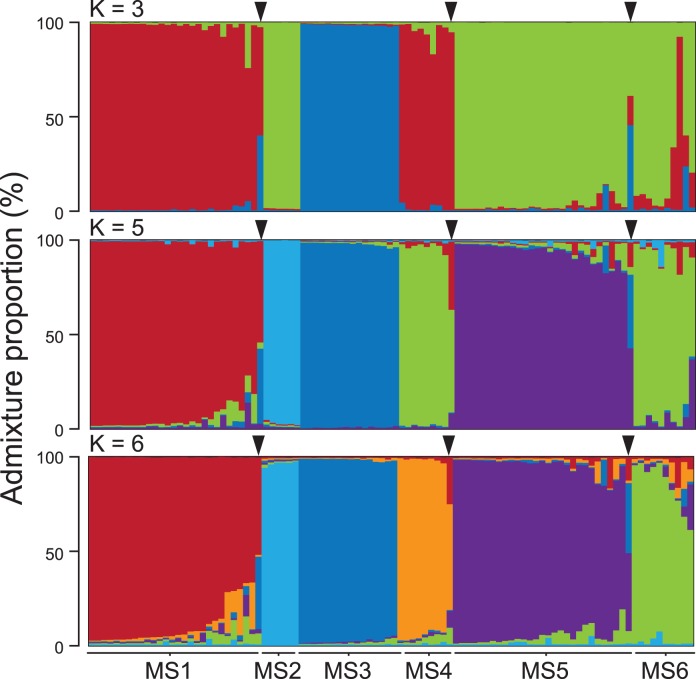
Admixture proportions based on STRUCTURE clustering of five microsatellite loci.Analysis of 98 samples (bars) of Decacrema ants inhabiting Macaranga in Lambir Hills National Park yielded six genetic clusters (MS1–MS6), which are color coded here for K = 3, 5, and 6. Triangles indicate samples that appear to be admixtures of two genetic clusters, suggesting hybridization.